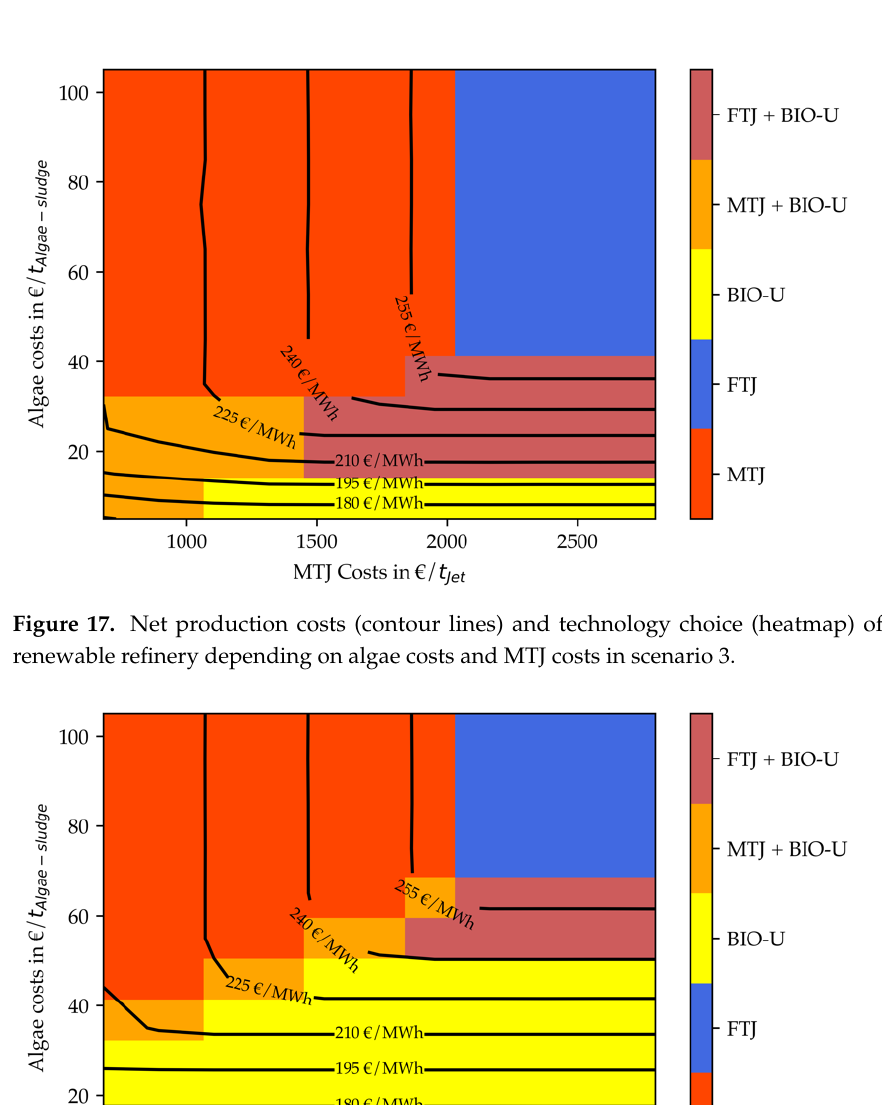
Figure 17. Net production costs (contour lines) and technology choice (heatmap) of optimized re- newable refinery depending on algae costs and MTJ costs in scenario 3. Figure 18. Net production costs (contour lines) and technology choice (heatmap) of